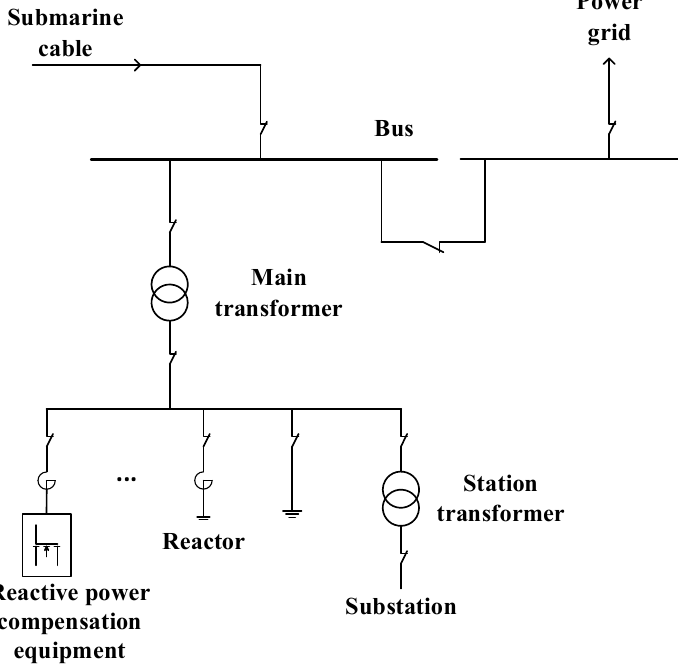
Figure 6. The structure of the onshore part of the offshore wind farm.